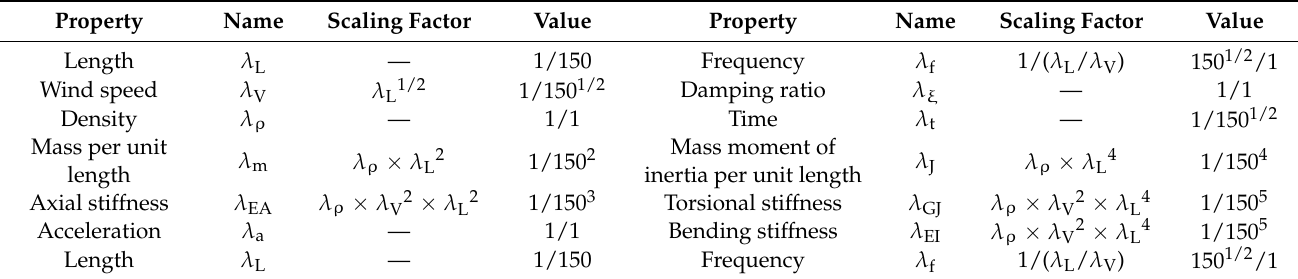
Table 5. Scaling parameters for Froude number